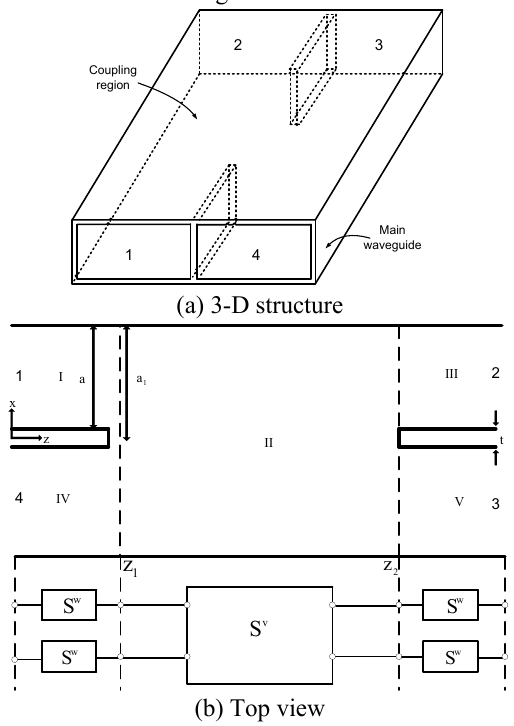
Figure 1: Configuration of the directional